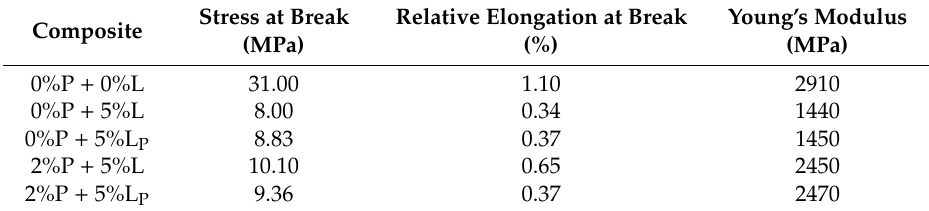
Table 2. Results of mechanical tensile stress.